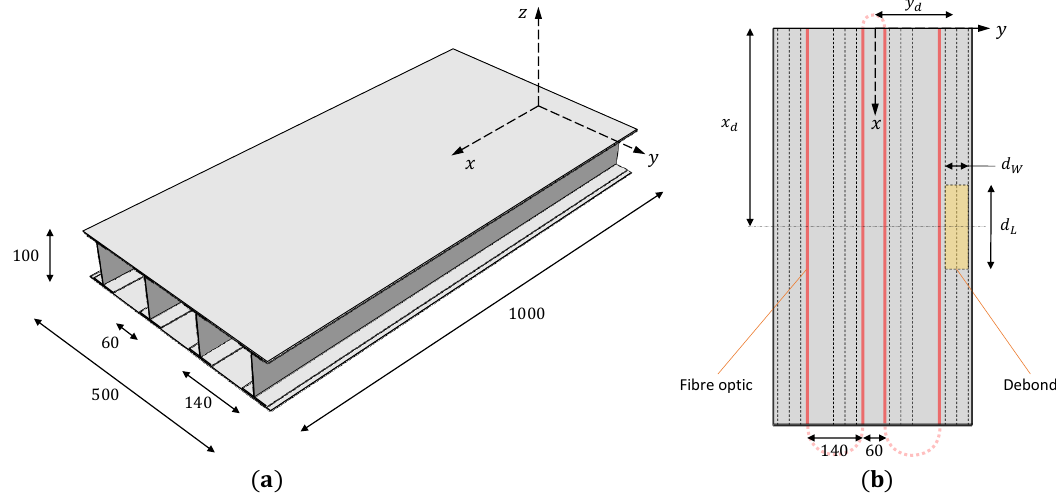
Figure 14. Illustration of the composite wing box showing the ( a ) geometric dimensions, ( b ) position of the fiber optic sensors, and the debonded area on the top skin (all dimensions are in mm). A high-fidelity FE model of the wing box is developed in ABAQUS to simulate its mechanical behavior. The wing box is modeled using 5600 S4R elements, as shown in Figure 15. Over the debonded region, the skin and the spar cap are meshed separately using 64 shell elements, with displacement and rotation continuity maintained at the debond junctions [54]. An additional contact constraint is also introduced between skin and spar elements to avoid intersections during deformation. The FE strains are used as inputs for the iFEM analysis, and the FE displacements are the reference for comparisons. The iFEM model uses the same element discretization scheme as the direct model but employs the inverse shell element iQS4 [25]. Only the upper and lower skins of the wing box are assessed for debond detection, where the iFEM results are smoothed using a 10 × 10 SEA3 smoothing mesh shown in Figure 15.